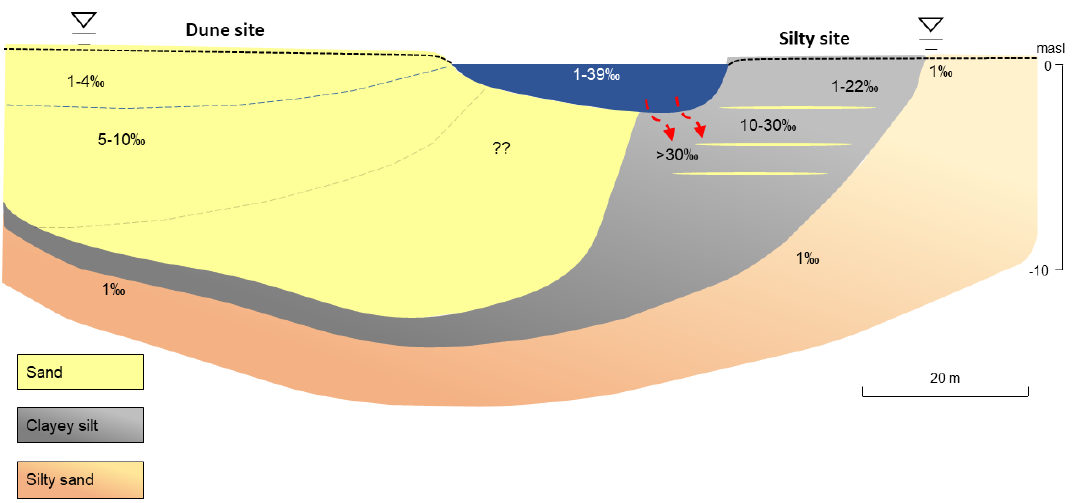
water Figure 11. Hydrogeological conceptual model, showing the suggested location of the different water bodies.